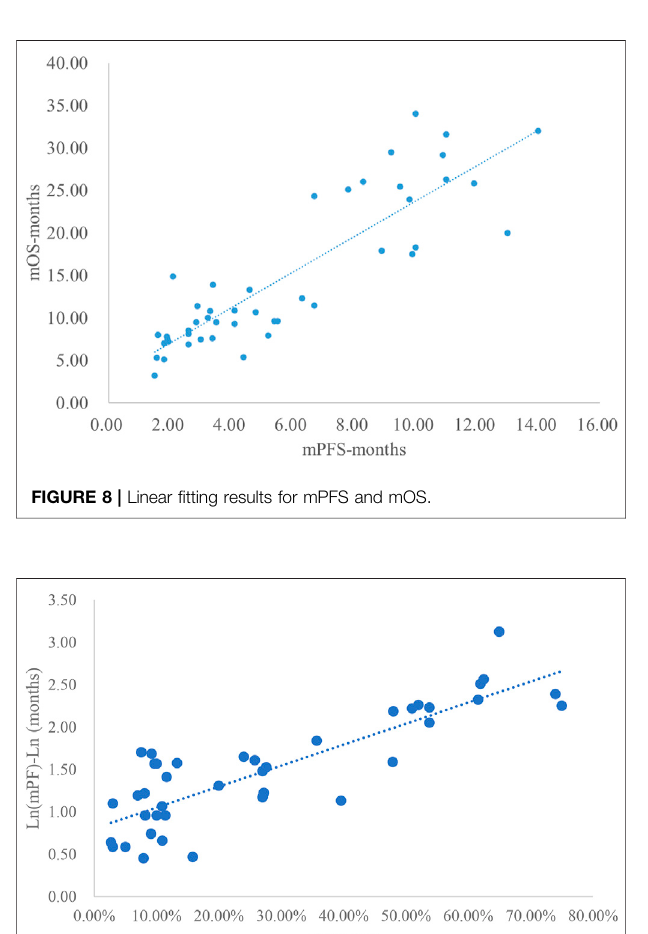
FIGURE 12 | Linear fi tting results for mPFS and